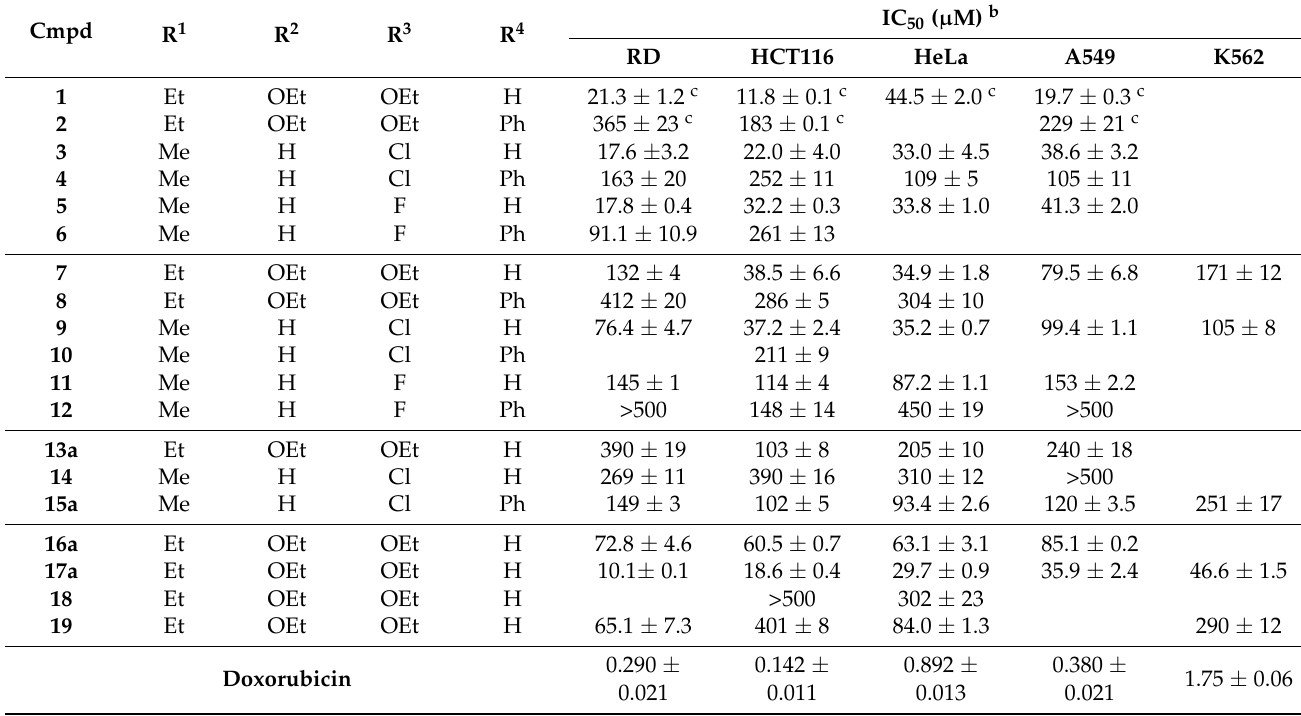
Table 1. Cytotoxic activity of 5,6-dihydro-1-phenylpyrrolo[2,1- a ]isoquinoline (DHPPIQ) derivatives against a panel of tumor cell lines.